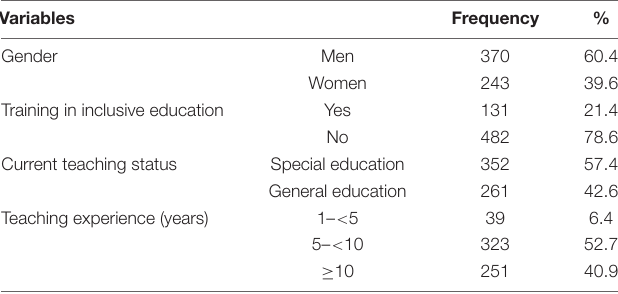
TABLE 2 | Interpretation of average mean ORI scores of attitudes toward inclusion.